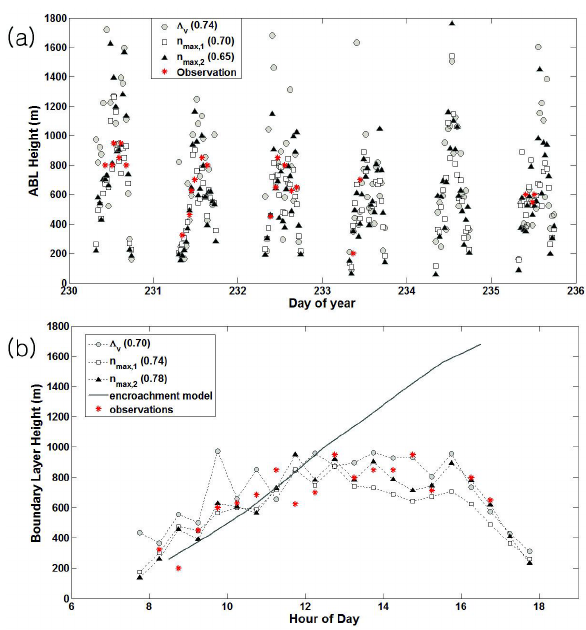
Figure 7. (a) Time-series and (b) mean diurnal patterns of estimated z i and corresponding observations during the tether sonde measurements from day 230~235 (8/18/2007~8/23/2007) for unstable conditions (07:30~17:30). Gray circles represent z i estimates from v , white squares estimates from n max , 1 , and black triangles from n max,2 . Red asterisks denote the observations and thick gray solid line represents the result of an encroachment model expressed in Eq. (7). The values in parentheses within the legend show the correlation coefficients between diurnally averaged estimates from each method and the observations.